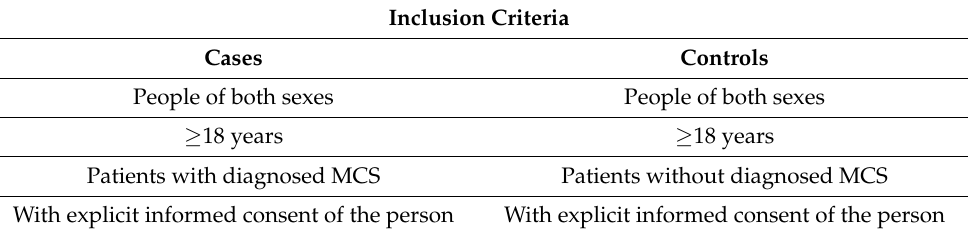
Table 3. Inclusion criteria to take part in the